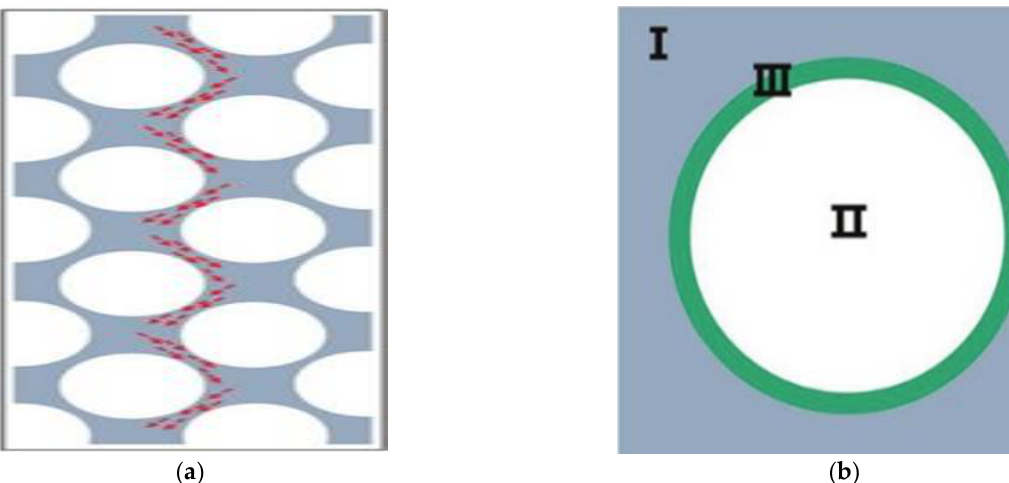
Figure 10. Microstructure between glass microspheres/matrix ( a ) Schematic of typical three-stage heat conduction; ( b ) Heat conduction of composite solids. ( a , b ) Adapted with permission [55], Copyright 2018, Advanced Materials.